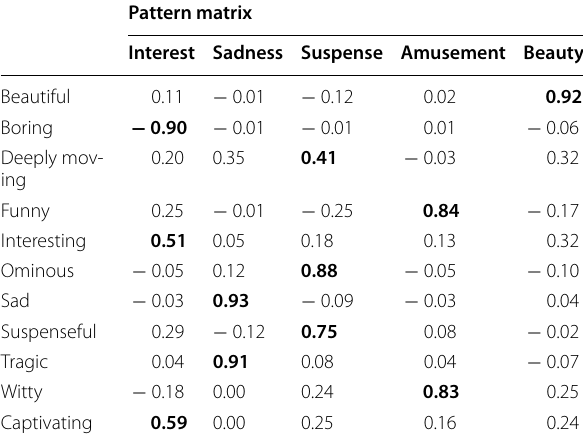
Factor loadings over .40 appear in bold